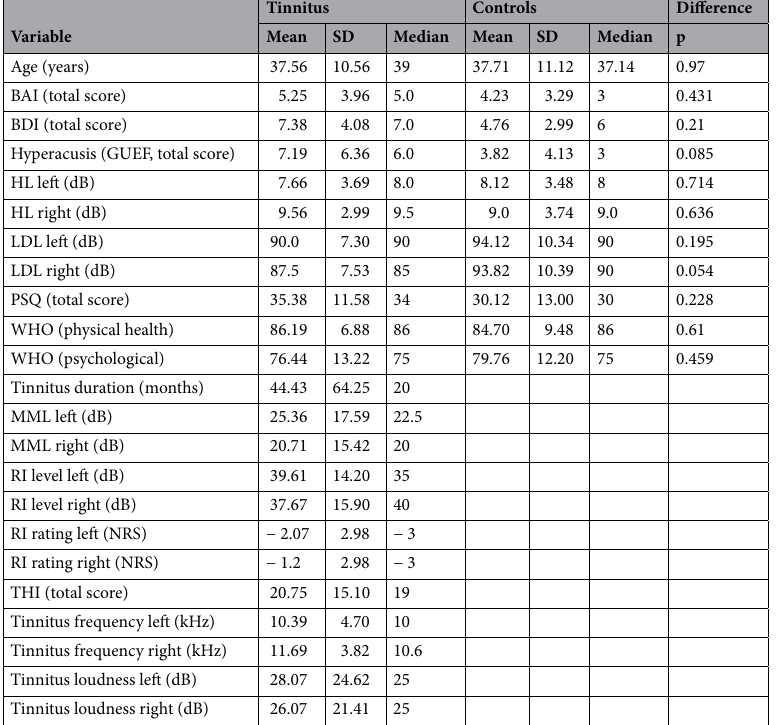
Table 1. Participant characteristics. N = 33 (16 tinnitus, 17 controls). All dB values are dB HL. Left and right refer to the two ears. SD standard deviation, NRS numeric rating scale, BAI Beck Anxiety Inventory 37 , BDI Beck Depression Inventory 36 , GUEF Geräuscheüberempfindlichkeits-Fragebogen 41 , HL hearing loss, LDL loudness discomfort level, PSQ Perceived Stress Questionnaire 34,35 , WHO WHO (quality of life-BREF) 33 , MML minimal masking level, RI residual inhibition, THI Tinnitus Handicap Inventory 39,40